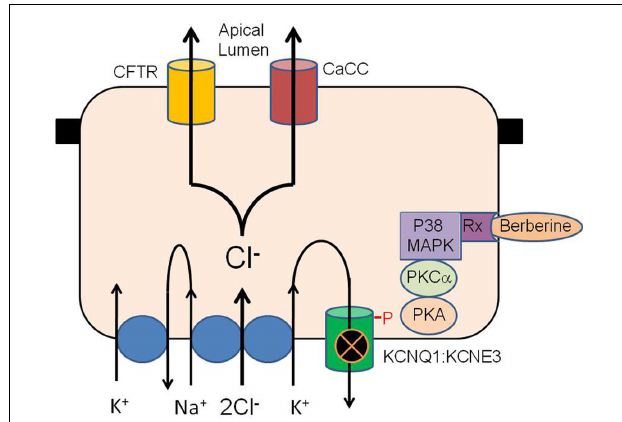
FIGURE 8 | Hypothetical schema of the antisecretory action of berberine in intestinal epithelium. Berberine activates p38 MAPK, PKC α and PKA to phosphorylate the KCNQ1:KCNE3 K + channel causing the channel to become inactive either through closure or removal from the plasma membrane. Inhibition of basolateral K + channel reduces the electrical driving force for Cl − exit across the apical membrane through CFTR and calcium-activated Cl − channels.The receptor transducing the response to berberine may be the estrogen receptor or GPR30/GPCR as previously described for similar antisecretory and rapid protein kinase responses to estrogen in the intestine.